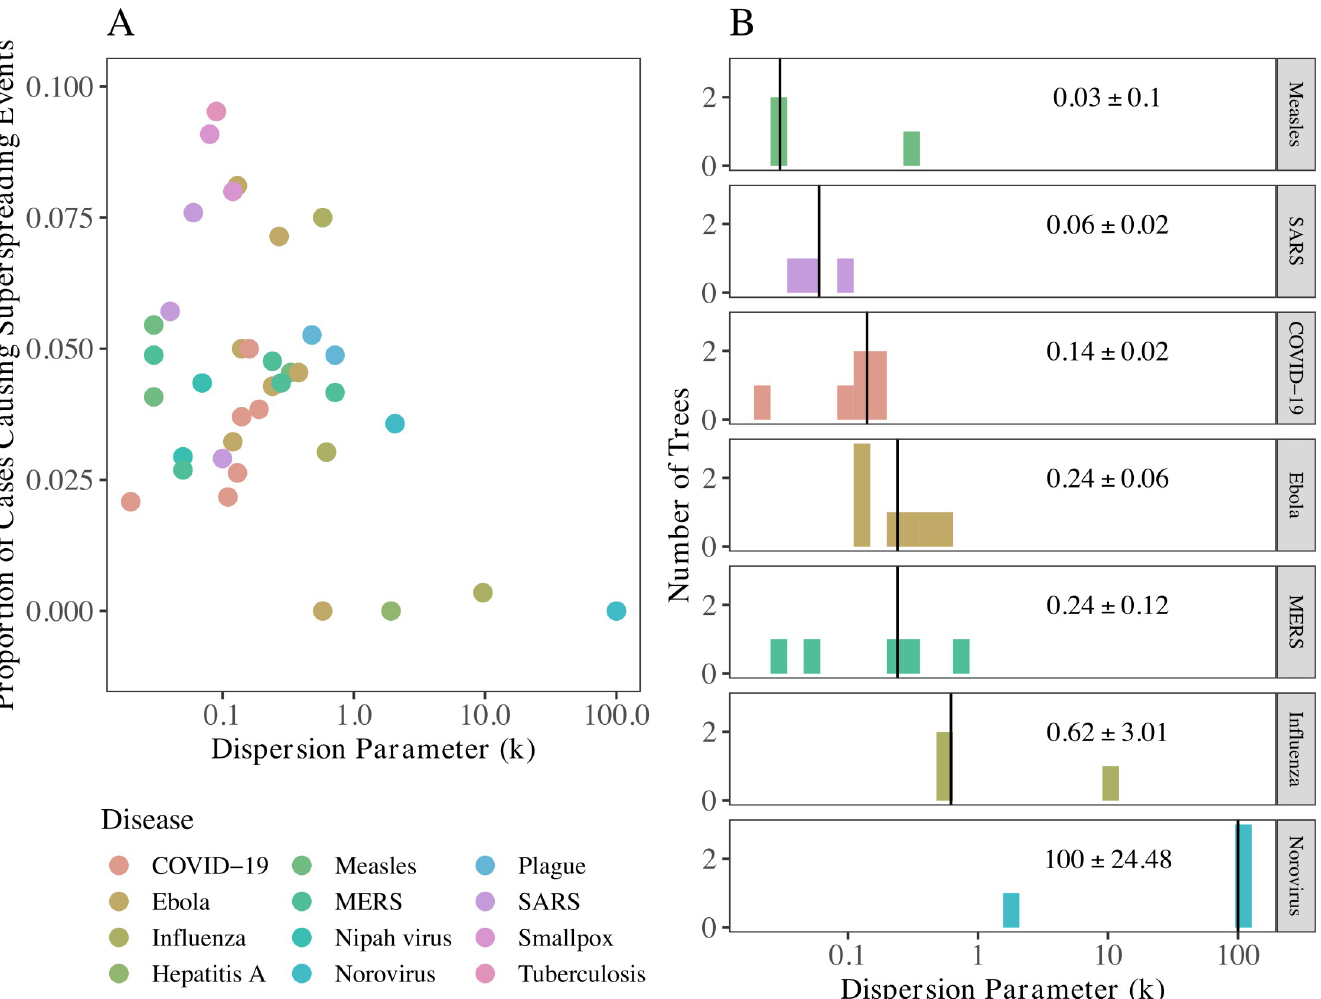
Fig 4. The importance and expected frequency of superspreading across diseases. (A) The highest proportion of cases causing superspreading events is observed at intermediate dispersion parameters, as predicted by theory [3]. (B) Dispersion parameter ( k ) of a negative binomial distribution fit to the offspring distribution of trees by disease (for diseases with at least 3 trees). Lower dispersion parameters are indicative of greater variation in number of secondary infections. Vertical line and value printed in each facet shows the median k and standard error for each disease. X-axes are on a log 10 scale in both plots for visual aid. Trees were assumed to be complete and only trees with 20 or more cases and at least 2 generations of spread were used in these analyses. Other size cutoffs are shown in S4 and S5 Figs and results assuming tree incompleteness are shown in S6 Fig. The data to reproduce this figure can be found at https://doi.org/10.5061/dryad.nk98sf7w7. COVID-19, Coronavirus Disease 2019; MERS, Middle East Respiratory Syndrome; SARS, Severe Acute Respiratory